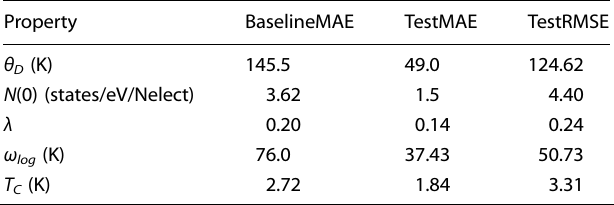
Table 3. DL model performance for direct property predictions. We compare the mean absolute error (MAE) of a baseline model, the MAE for the DL model on the 5% test data, and the root mean squared error (RMSE) for the 5% test data. The baseline model always predicts the mean of the target values in the training dataset.